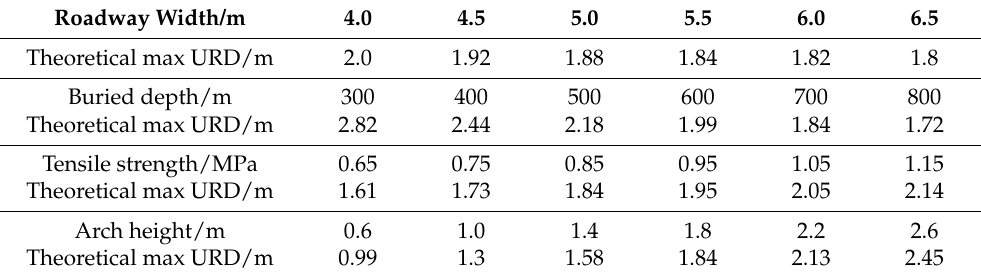
Table 1. Maximum URDs under different influencing factors.